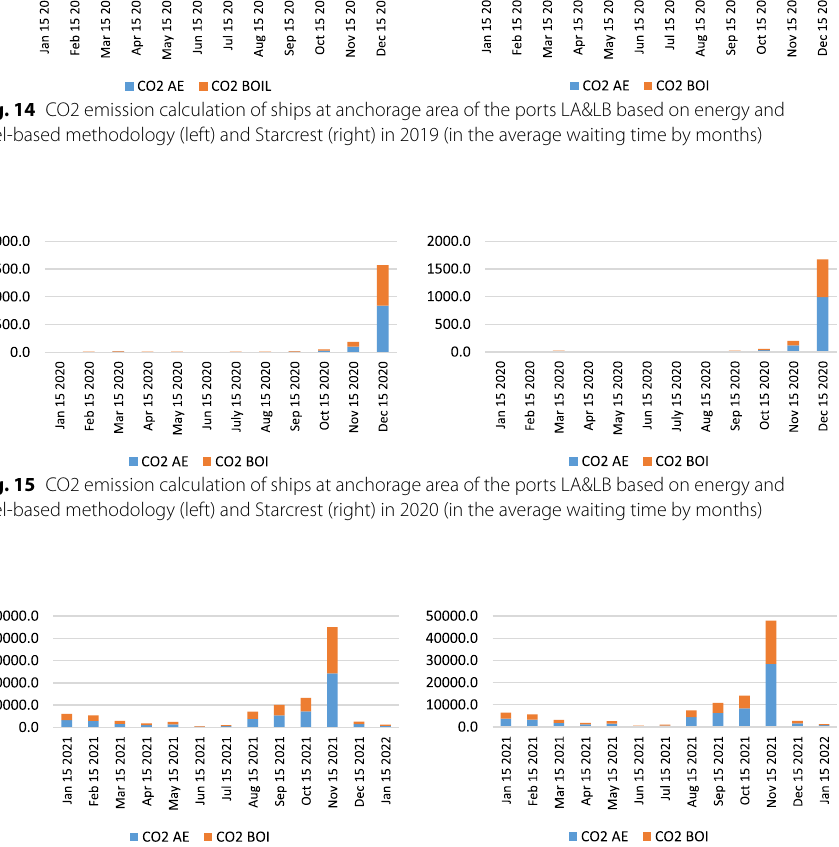
Fig. 16 CO2 emission calculation of ships at anchorage area of the ports LA&LB based on energy and fuel‑based methodology (left) and Starcrest (right) in 2021 (in the average waiting time by